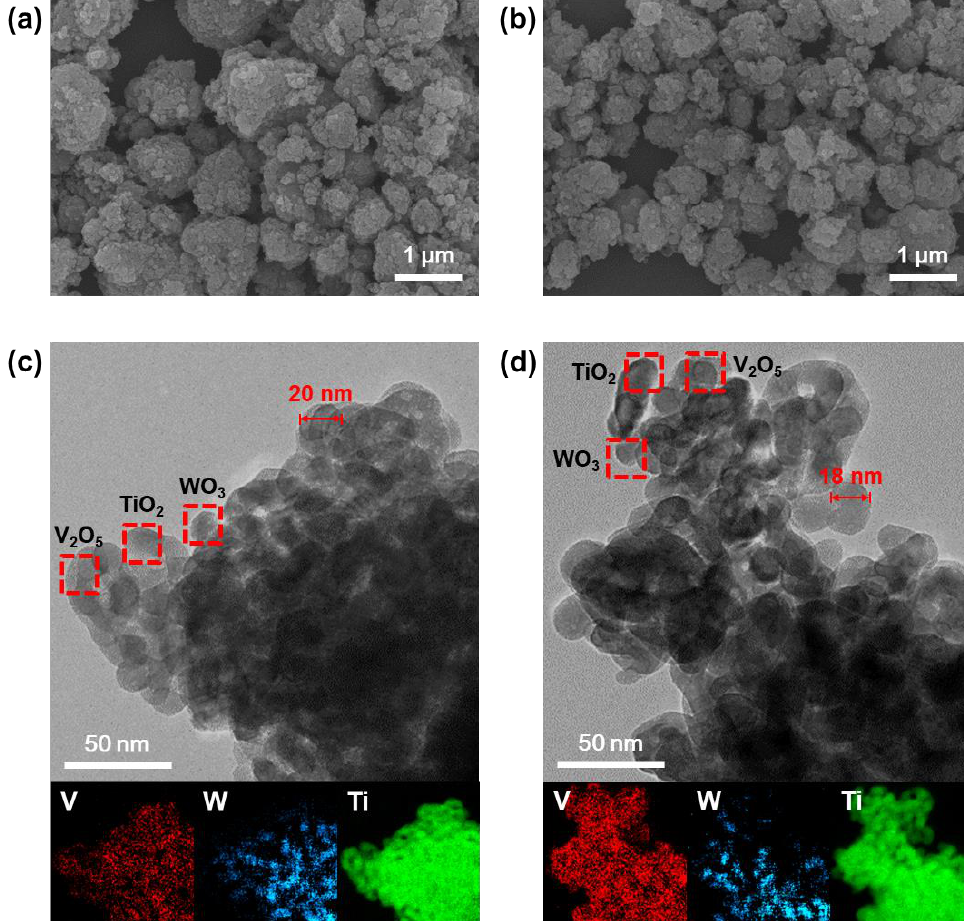
Figure 1. SEM images of the V 2 O 5 -WO 3 /TiO 2 prepared by the ( a ) one-sided heating and ( b ) isotropic heating methods. TEM images of the V 2 O 5 -WO 3 /TiO 2 prepared by the ( c ) one-sided heating and ( d ) isotropic heating methods (insets show the EELS elemental mapping of V, W, and Ti). Table 1. Brunauer – Emmet – Teller (BET) results of the V 2 O 5 -WO 3 /TiO 2 prepared by the one-sided Table 2. X-ray fluorescence analysis of the V 2 O 5 -WO 3 /TiO 2 prepared by the one-sided heating and isotropic heating methods.